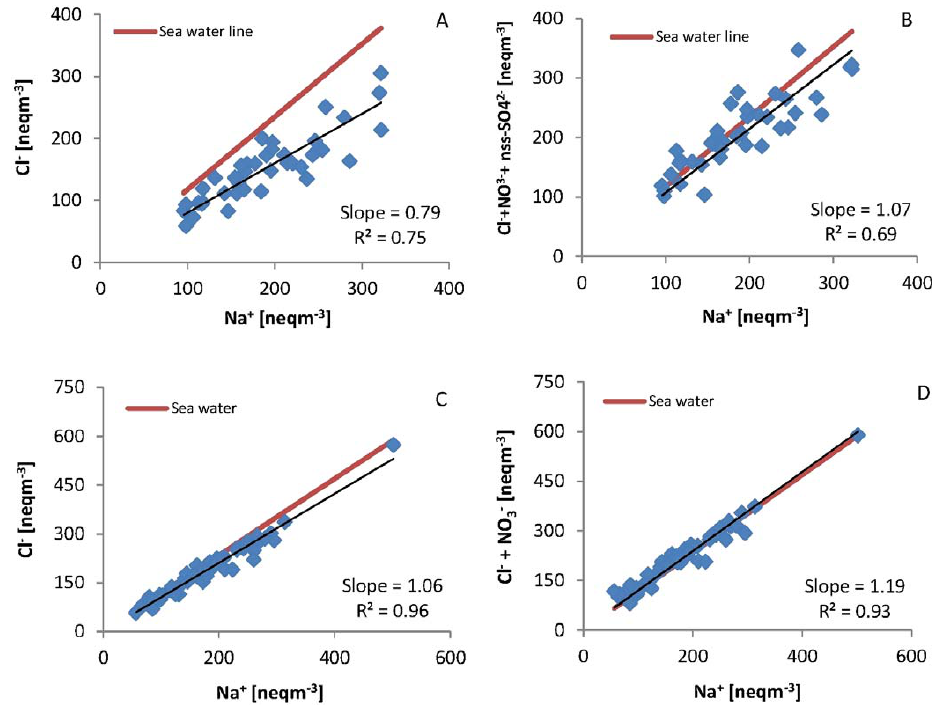
+ nss-SO 2 − during summer marine air mass inflow and 3 4 during Saharan dust events at the CVAO. 3